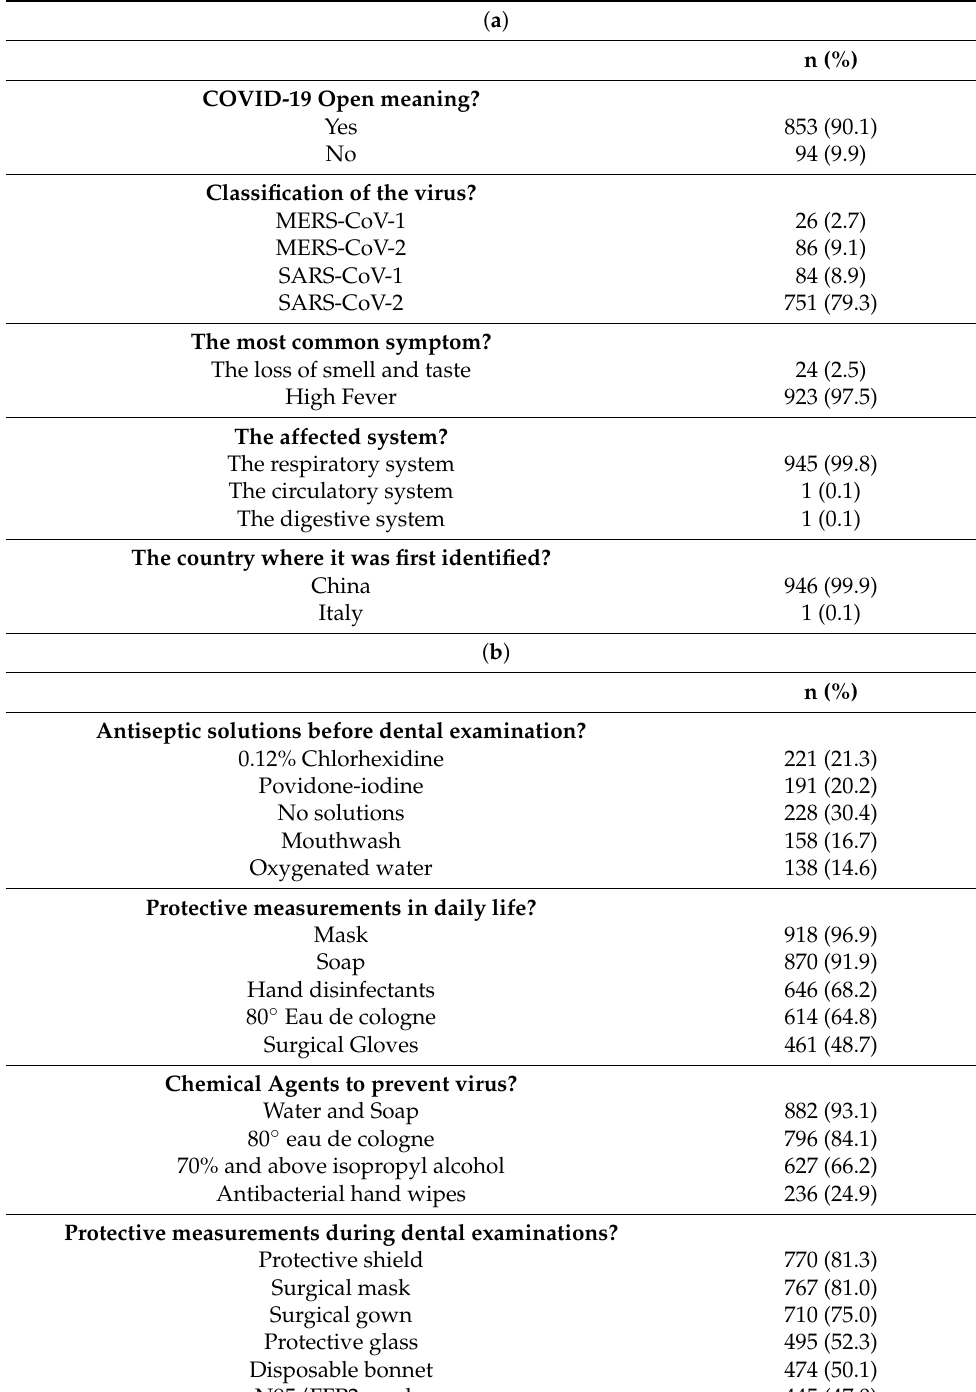
Table 2. ( a ) Knowledge regarding COVID-19. ( b ) Knowledge regarding protective